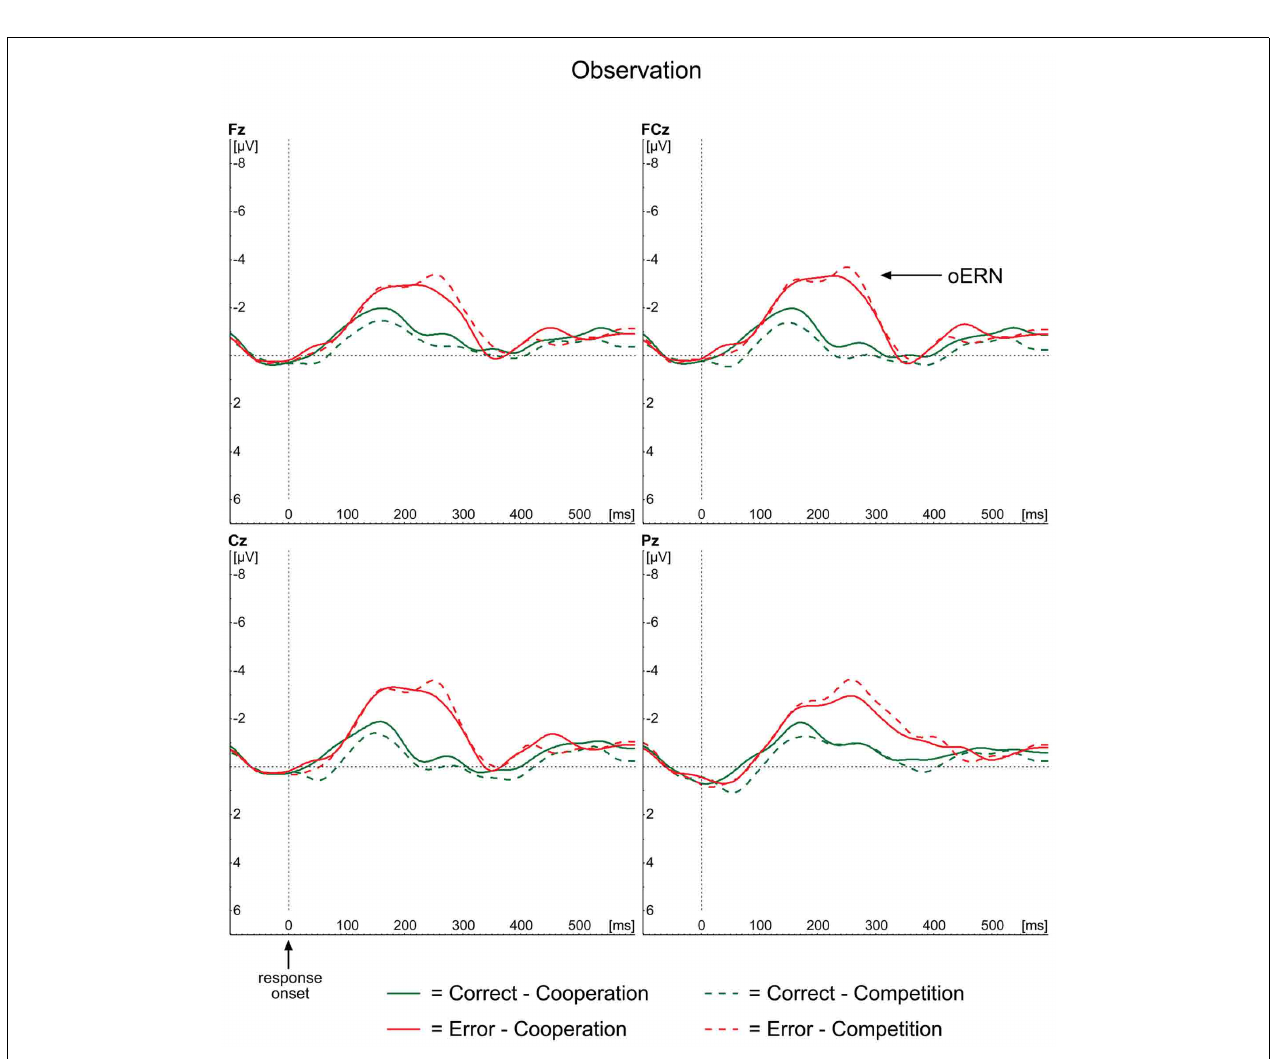
FIGURE 4 | Grand average ERP waveforms for the observation condition, time-locked to the onset of the actor’s response for correct (green lines) and incorrect (red lines) responses separately. Midline electrodes Fz, FCz, Cz, and Pz are depicted.